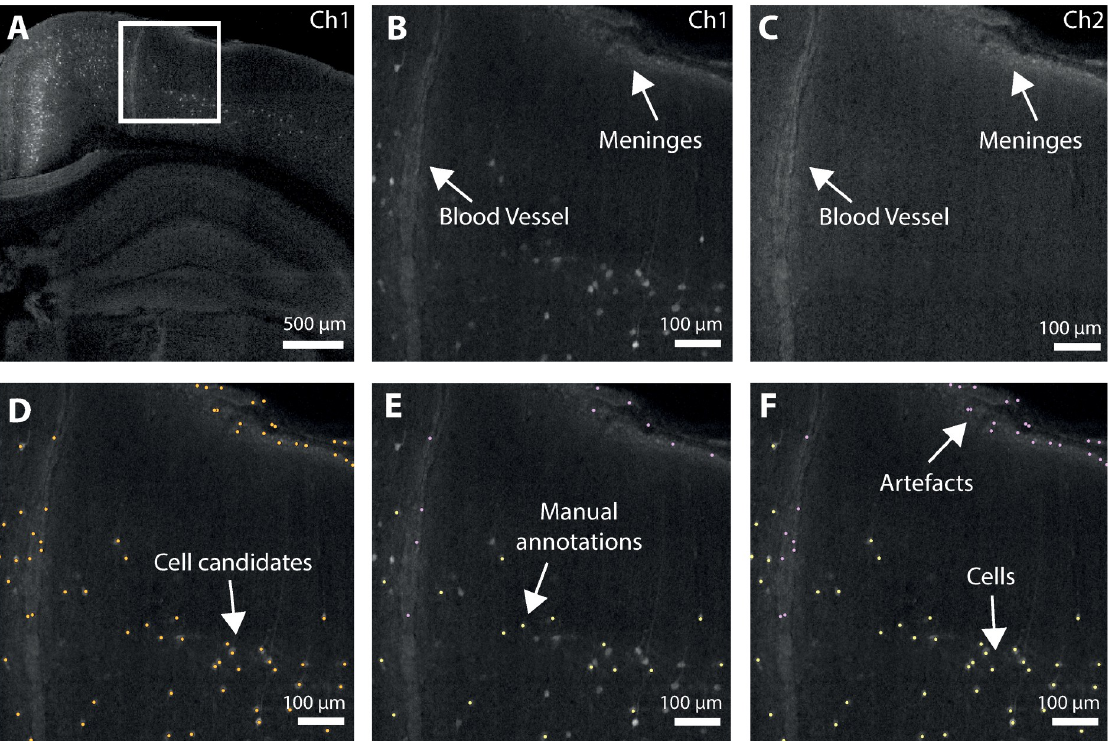
Fig 2. Illustration of the cell detection process. A: Single coronal plane of raw data (primary signal channel, Ch1). B: Enlarged insert of cortical region from A showing examples of structural features (artefacts) often erroneously detected. C: Cortical region shown in B, in the secondary autofluorescence channel (Ch2). Cells can only be seen in Ch1, but artefacts are visible in both channels. D: Detected cell candidates overlaid on raw data. Labelled cells as well as numerous artefacts are detected. E: Illustration of training data. A subset of detected cell candidates are classified as cells (yellow) or artefacts (purple). Cuboids of data centered on these selected cell candidates are then used to train the network. F: Classified cell candidates. The trained cell classification network is applied to all the cell candidates from (E) and correctly rejects the initial false